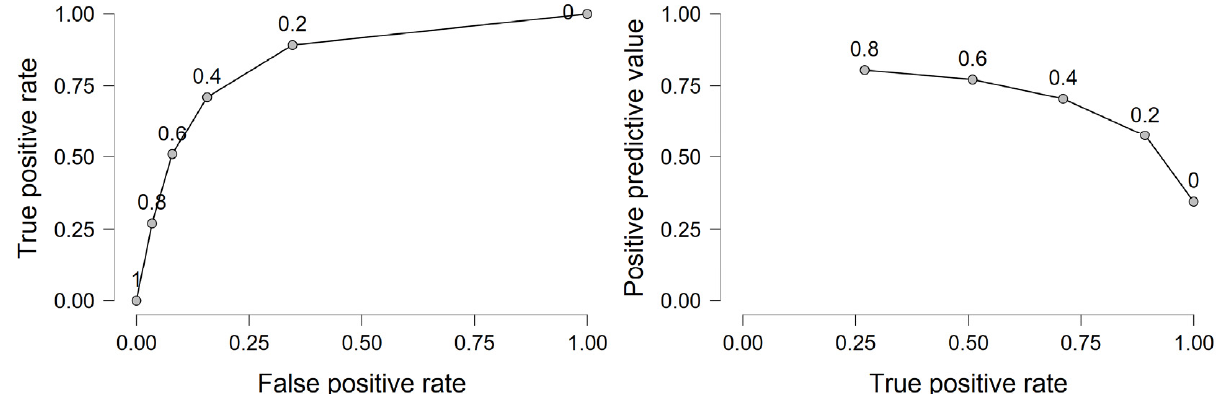
Figure 1. Sensitivity and specificity for the logistic model under study.